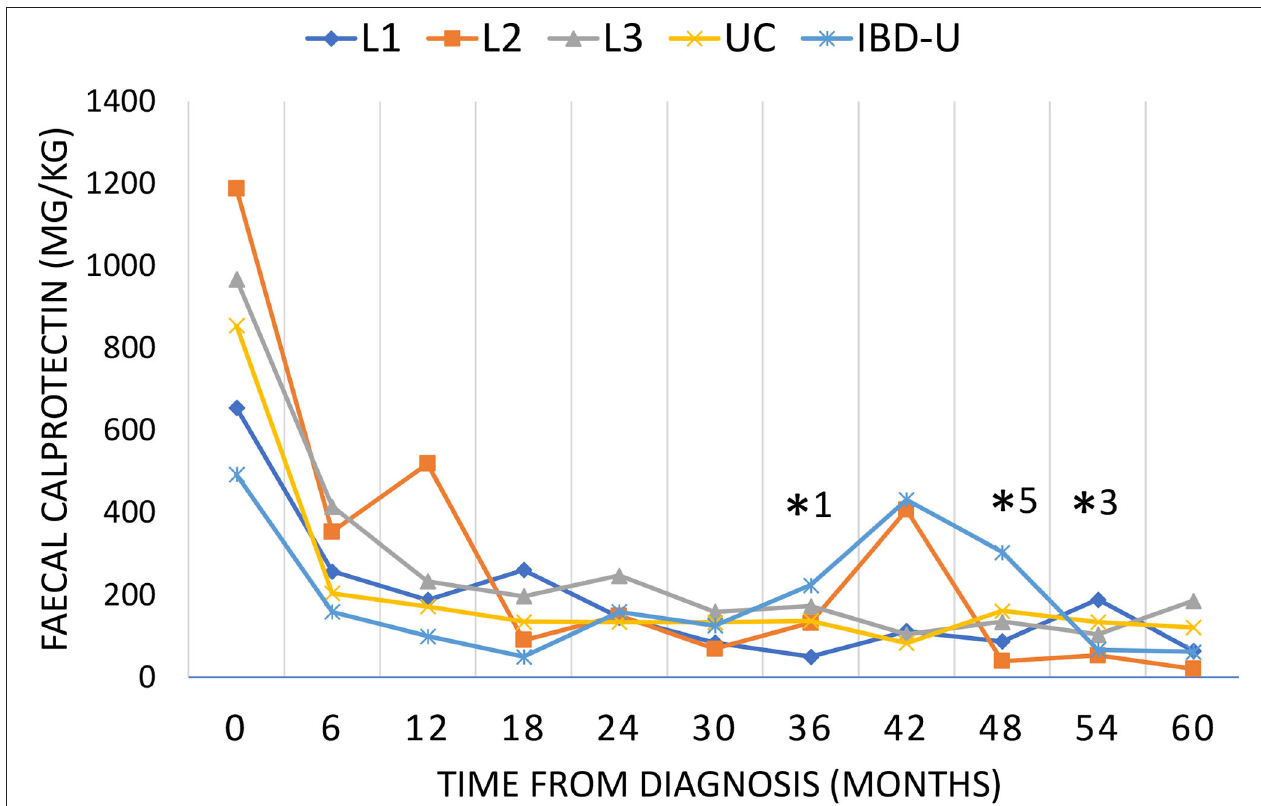
FIGURE 3 | Fecal calprotectin during the course of disease. Disease activity was evaluated by fecal calprotectin every 6 months for up to 60 months as long as the patients have been followed up. Fecal calprotectin is presented as median for each subgroup (L1, blue diamond; L2, orange square; L3, gray triangle; UC, yellow cross; IBD-U light blue star). Significant differences ( p < 0.05) were found for L2 compared to L1* 1 , IBD-U* 5 and L3* 3